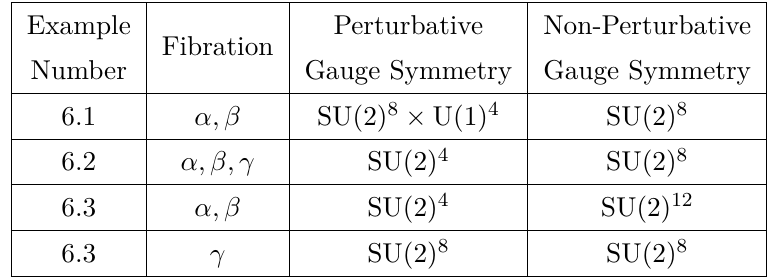
Table 2 . Summary of gauge symmetry in heterotic